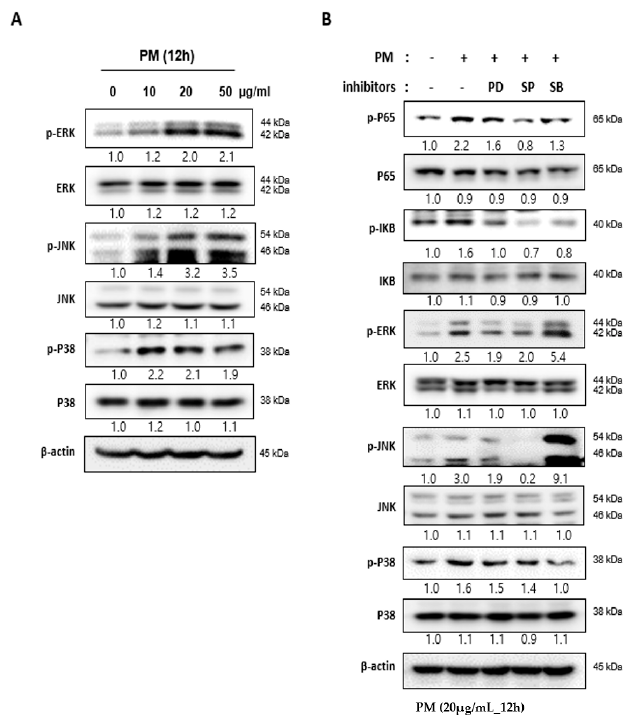
Figure 3. PM induces activity in the NF- κ B signaling pathway through the MAPK pathway. ( A ) The expression levels of the MAPK family members ERK, JNK, and P38 were evaluated by Western blot. The levels of p-ERK, p-JNK, and p-P38 expression increased according to the PM concentration. Cells were treated with various concentrations of PM (0–50 μ g/mL) for 12 h. ( B ) Increased expression of the protein associated with the activation of the MAPK signaling pathway was reduced by specific inhibitors (ERK inhibitor: PD98059; JNK inhibitor: SP600125; P38 inhibitor: SB203580). The increased expression of p-P65 after the PM treatment was also reduced by the inhibitors. Cells were treated with PM (20 μ g/mL) for 12 h.